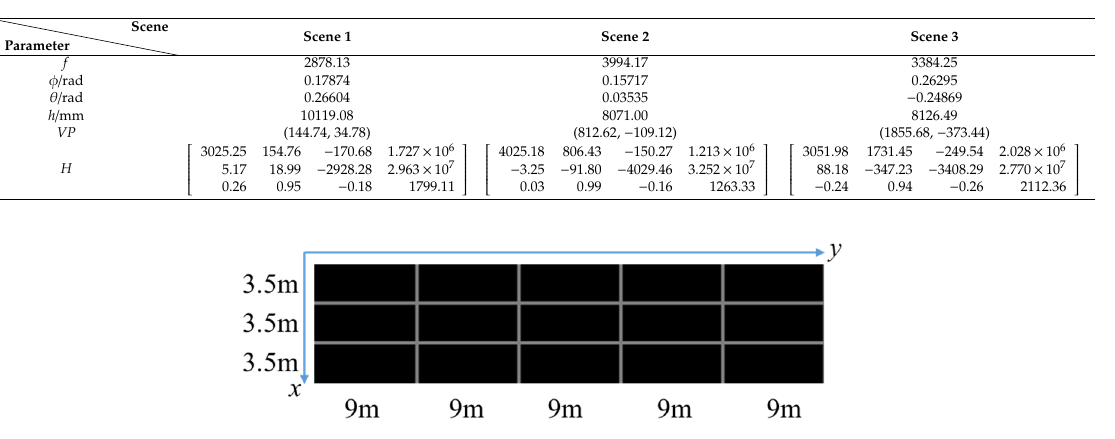
Figure 11. Schematic diagram of the roadblock.